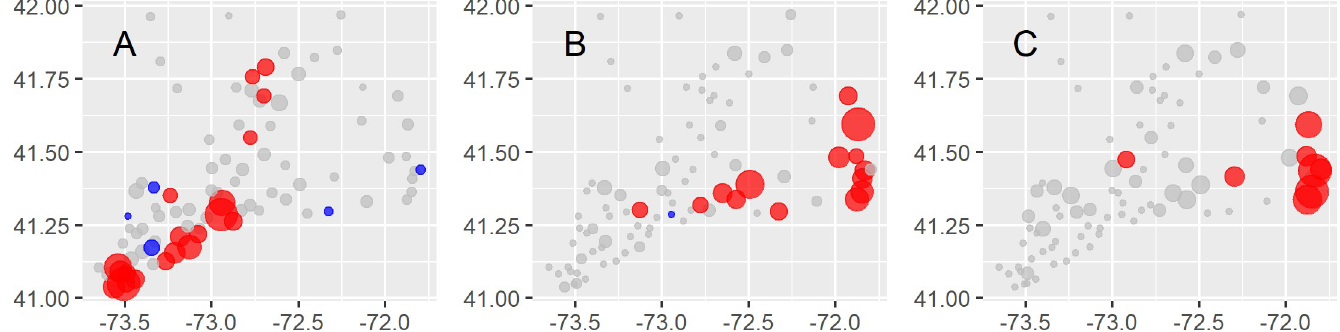
Fig 6. Risk maps for the avian arboviruses: West Nile virus (A), eastern equine encephalitis virus (B), and Highlands J virus (C). Point sizes correspond to the number of isolates scaled to the maximum number of isolates detected while colors indicate whether the 95% confidence interval for the odds of arbovirus detection were > 1 (red), included 1 (grey), or were < 1 (blue).